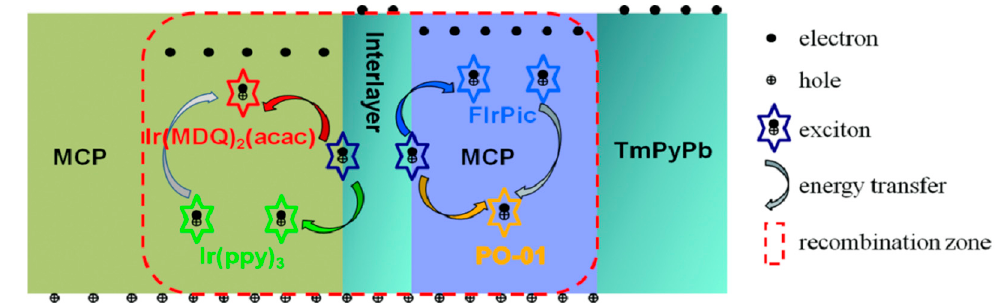
Figure 6. The emission mechanism of white devices A–D.